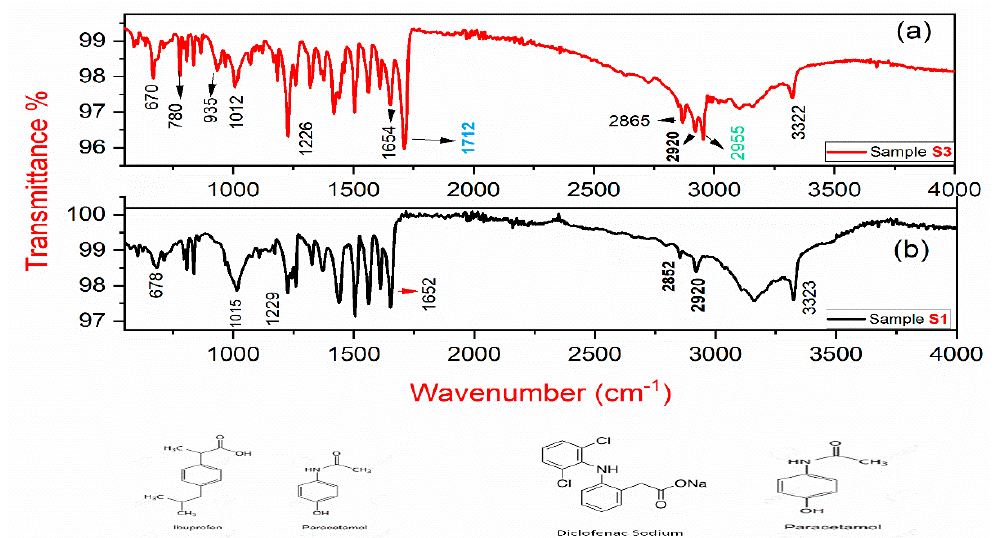
Figure 7. ( a ) FT-IR spectrum of sample S3; ( b ) the FT-IR spectrum of sample S1.